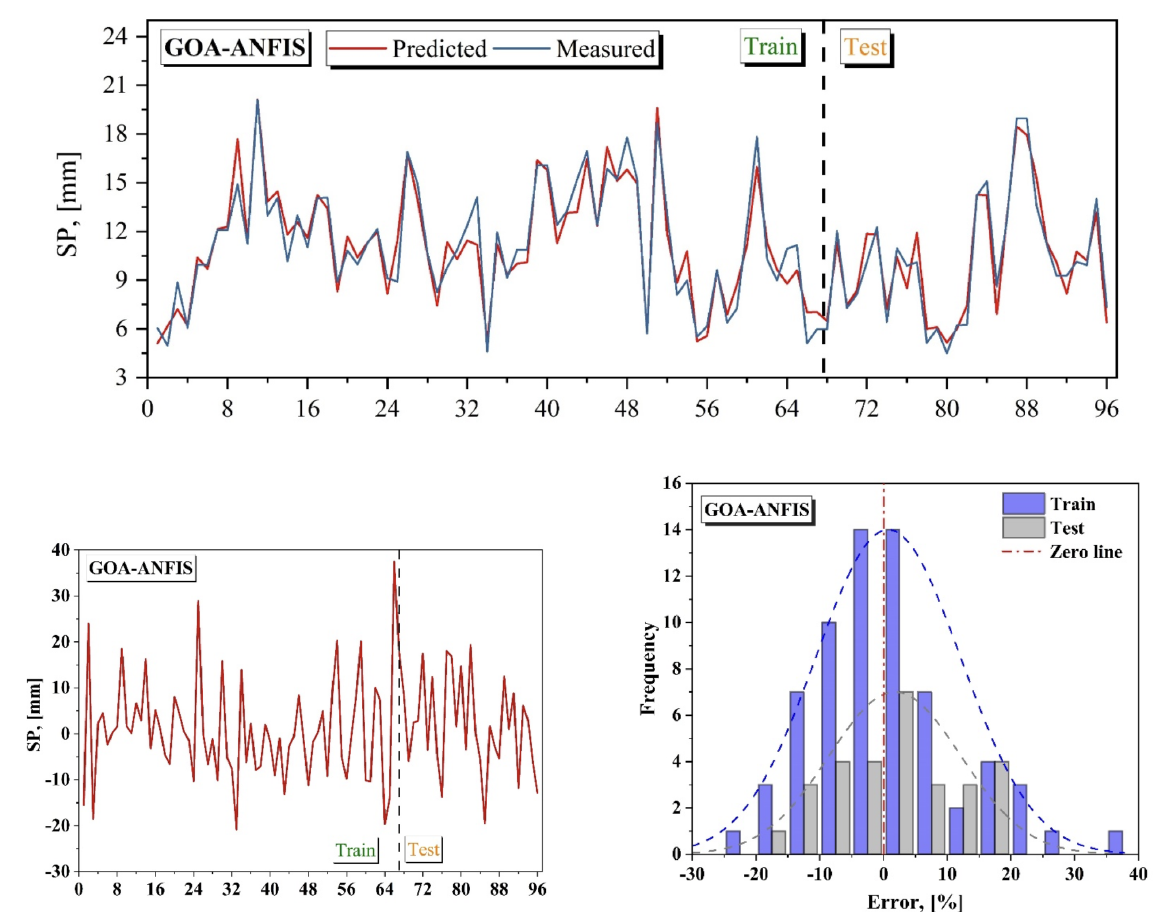
Fig. 13. Results of the introduced GOA-ANFIS model in predicting SP